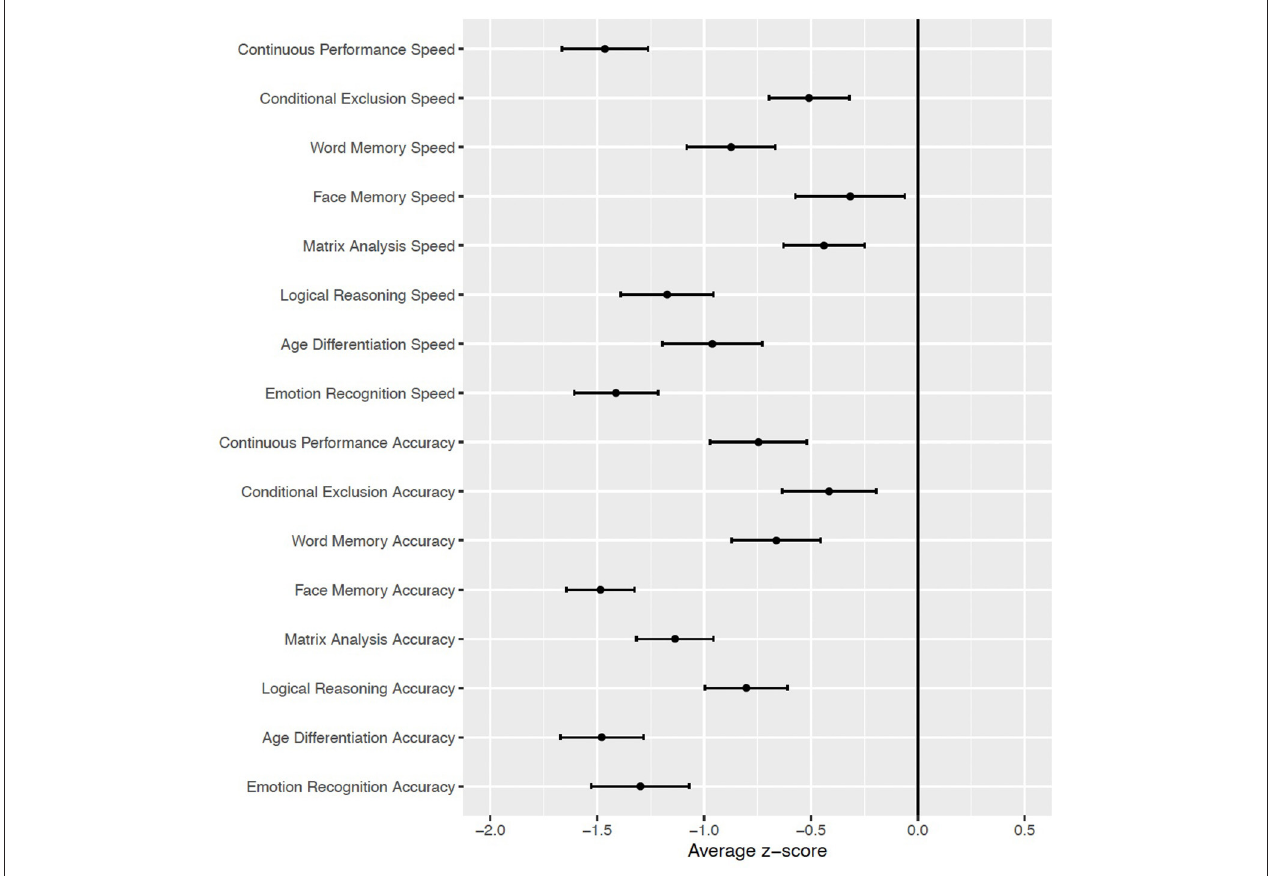
FIGURE 3 | Mean and standard error of neurocognitive domains in subjects with PWS ( n = 40), relative to typically developing youth cohort [Philadelphia Neurodevelopmental Cohort (